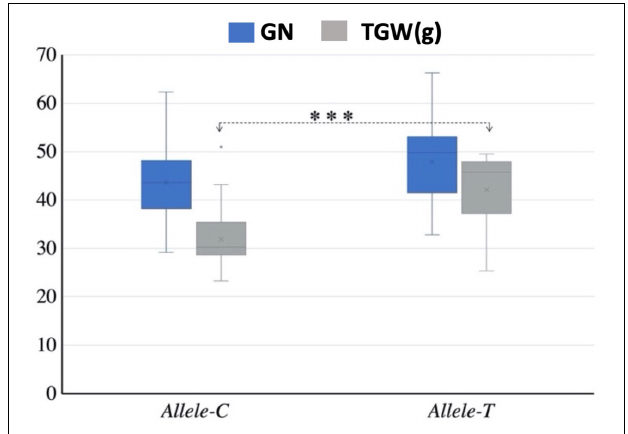
FIGURE 3 | Interaction of favorable allele with yield-related traits. TGW, thousand grain weight; GN, grain number; ∗ p < 0.05, ∗∗ p < 0.01. The 2-year data of 2017 and